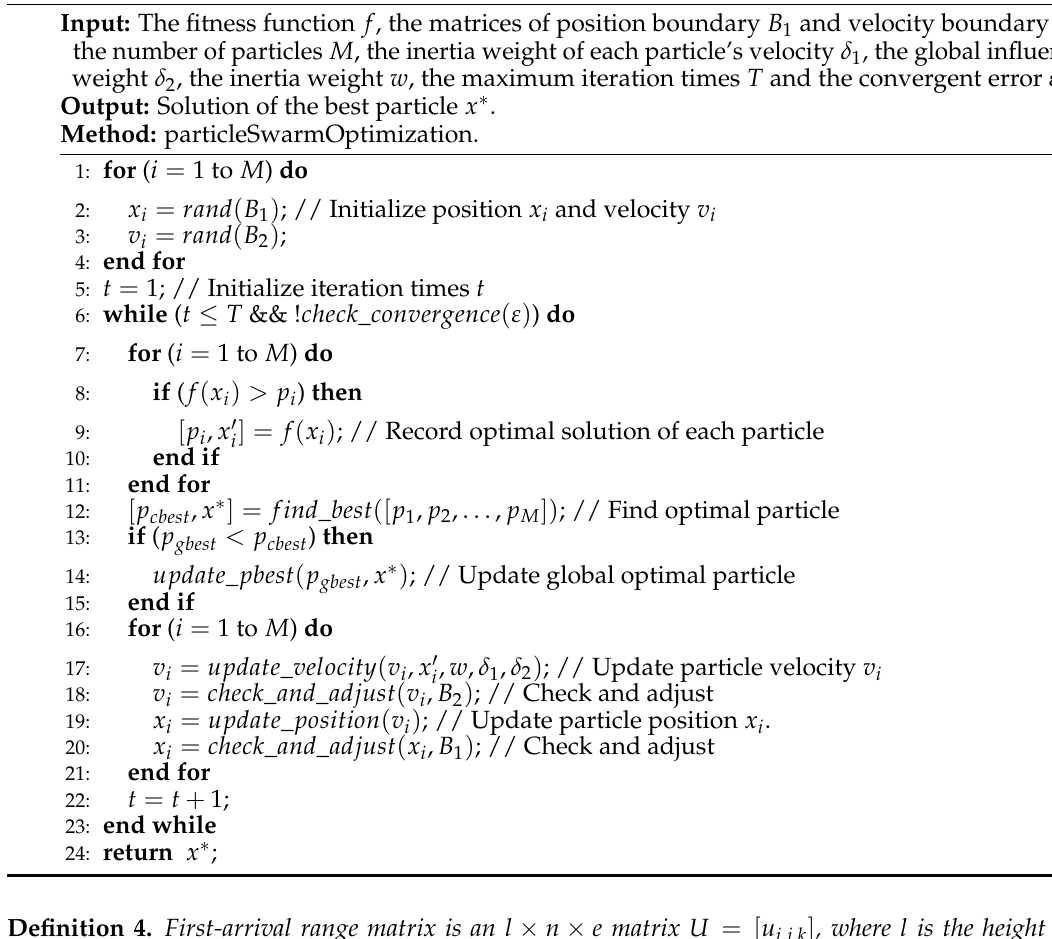
Algorithm 3: PSO